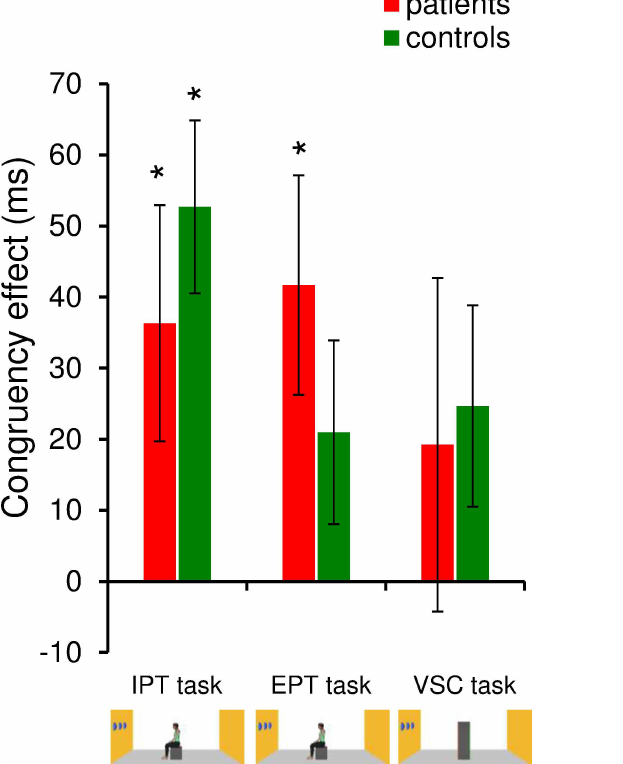
Fig 3. Results for the visuo-spatial perspective-taking tasks (Experiment 1; Congruency effects). Histograms represent the averagecongruency effect (incongruent viewpointminus congruent viewpoint) calculatedfor the implicit perspective-taking (IPT) task, explicit perspective-taking (EPT) task, and visuo- spatialcontrol (VSC) task for patients and controls. * indicatessignificantdifferenceswith respect to zero (t- test). Vertical bars representthe standard error of the